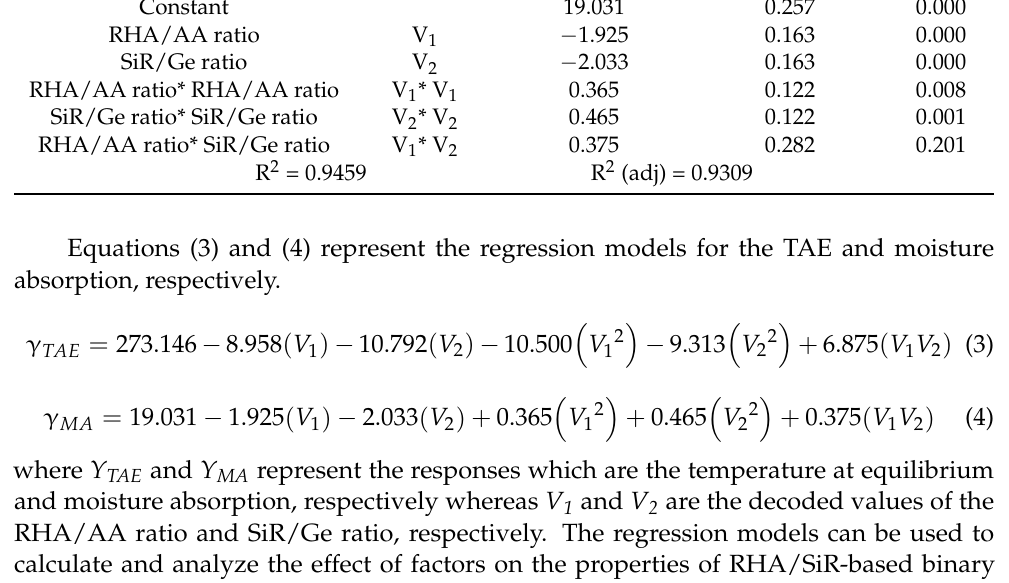
Standard Error p of Coefficient